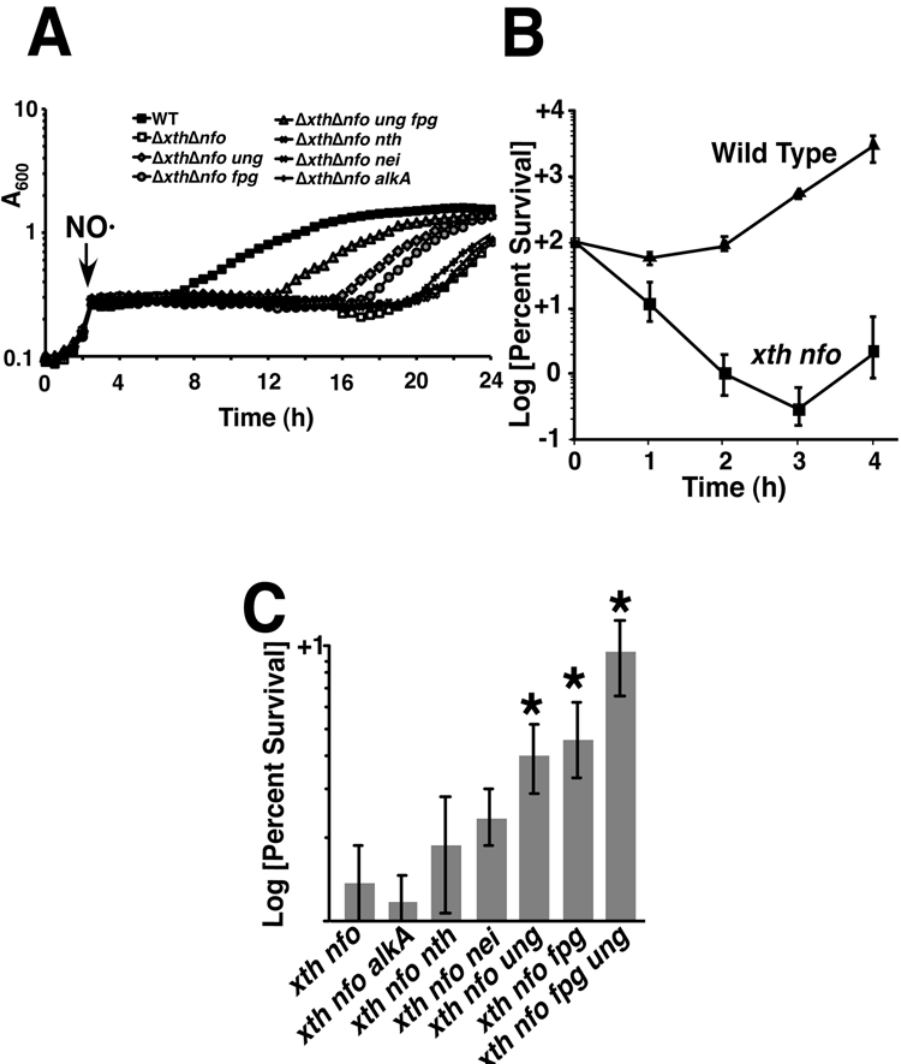
Figure 1. NO ? –sensitivity of S. Typhimurium Base Excision Repair mutants. (A) Growth of S. Typhimurium 14028s and mutant derivatives after the addition of NO ? from 2 mM SperNO (at arrow). (B) Survival of Wild Type and xth nfo after exposure to 1 mM SperNO. (C) Rescue of xth